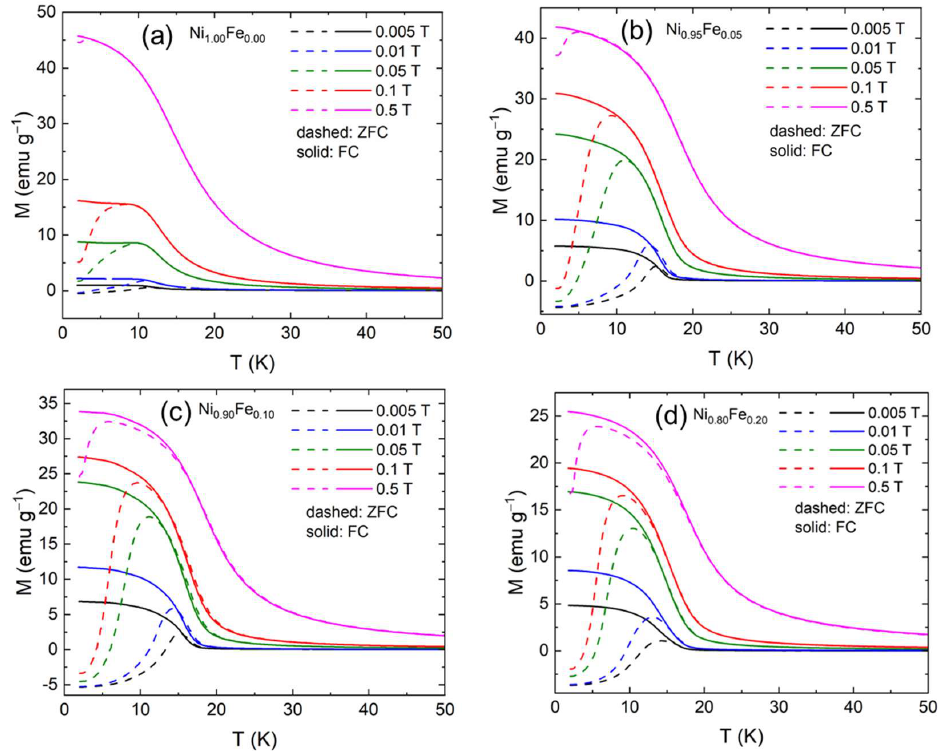
Figure 7. Zero field cooled ( ZFC) and field cooled (FC) susceptibilities for applied fields of 50 Oe, 100 Oe, 200 Oe, 500 Oe, 0.1 T, and 0.5 T. field for ( a ) Ni 1.00 Fe 0.00 (0% Fe), ( b ) Ni 0.95 Fe 0.05 (5% Fe), ( c ) Ni 0.90 Fe 0.10 (10% Fe), and ( d ) Ni 0.80 Fe 0.20 (20% Fe).